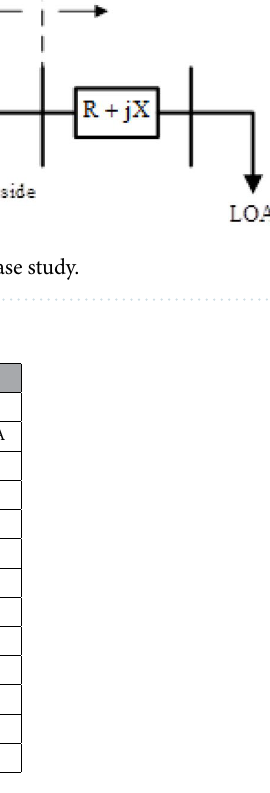
Table 1. Configuration of the power transformer using in case study.